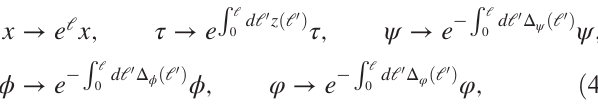
FIG. 3. Boson self-energies for the order parameter ( Σ ϕ ) and electrostatic ( Σ φ ) fields.